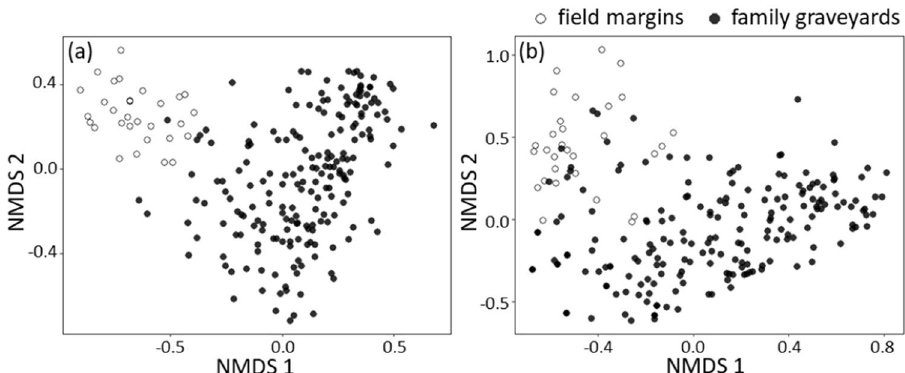
Figure 2. NMDS ordination plots based on the Bray–Curtis dissimilarity matrix reflecting ( a ) the overall plant species composition and ( b ) the insect-pollinated plant species composition at the sampling plots of two main habitat types—field margins and